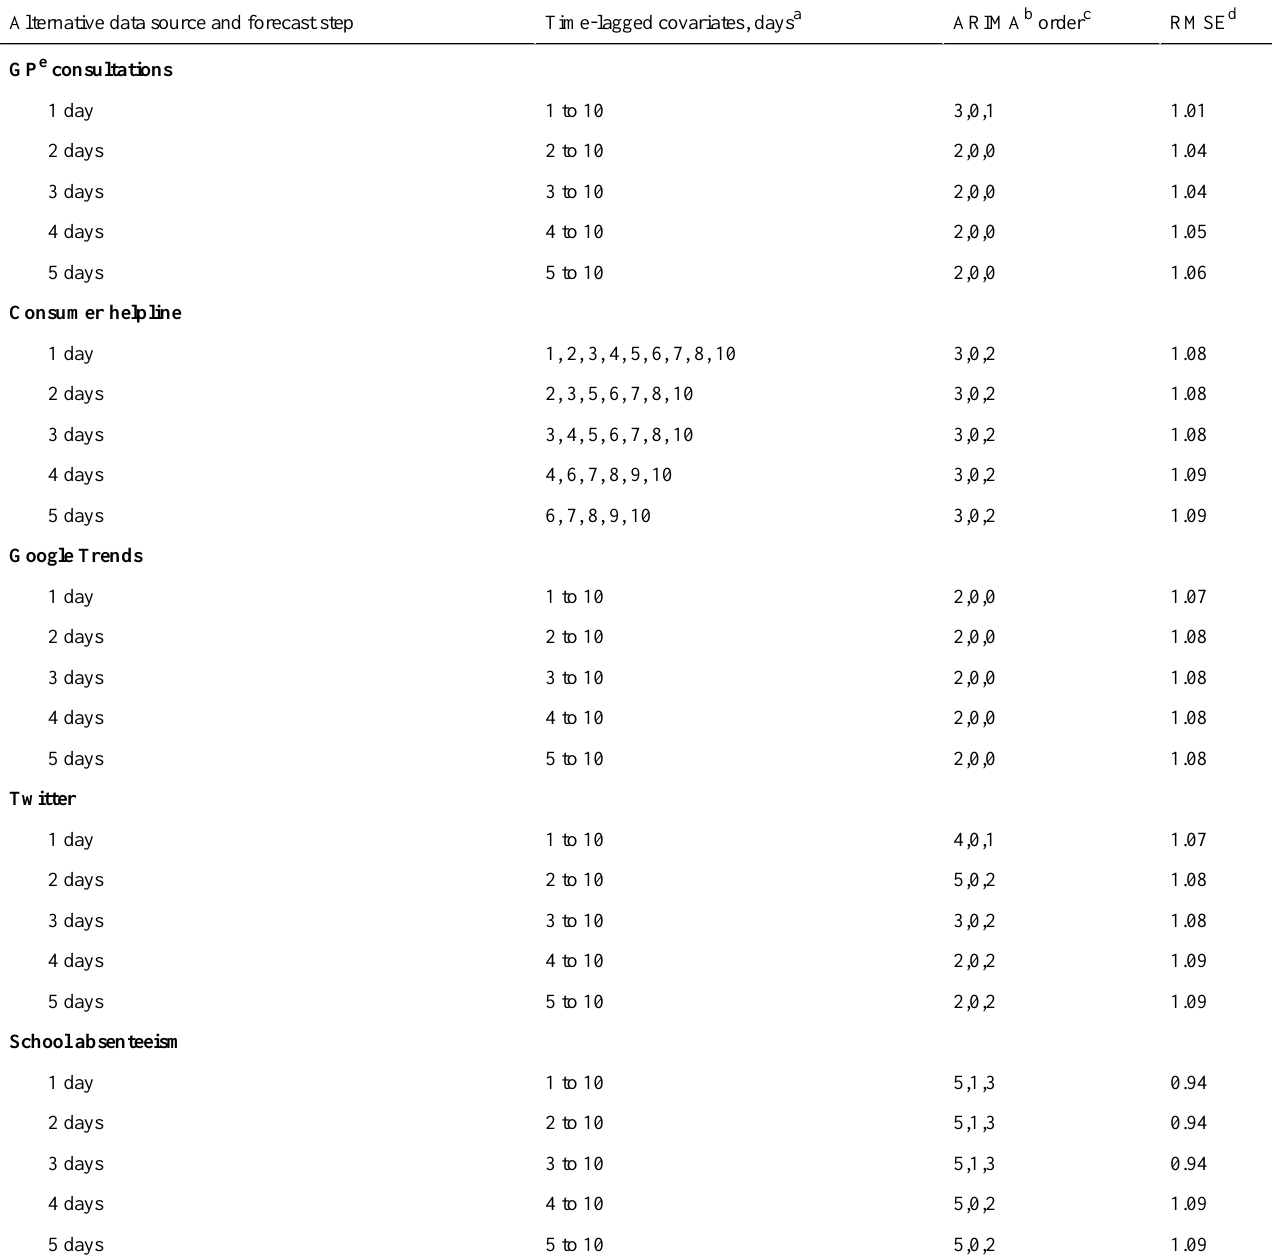
Table 3. Autoregressive integrated moving average models with time-lagged covariates used with alternative data sources for forecasting 1 to 5 days